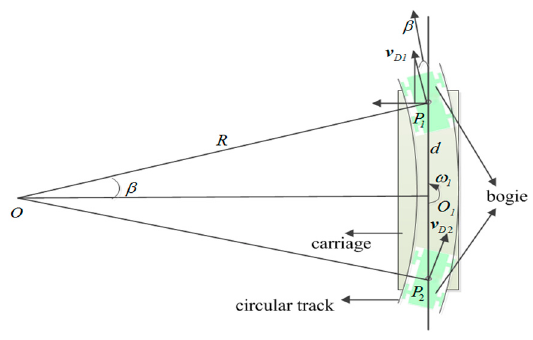
Figure 3. Geometric analysis of train turning.